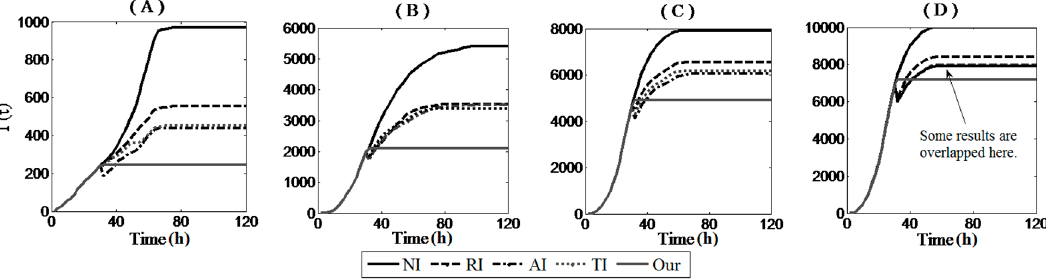
Figure 9. Number of infected nodes vs. propagation time when there are only immunization strategies, but no patches are implemented. The network sizes of ( A – D ) are 4000, 6000, 8000, and 10,000, respectively. We assume immunity rates are 20% and the immunization methods are executed at time 30.